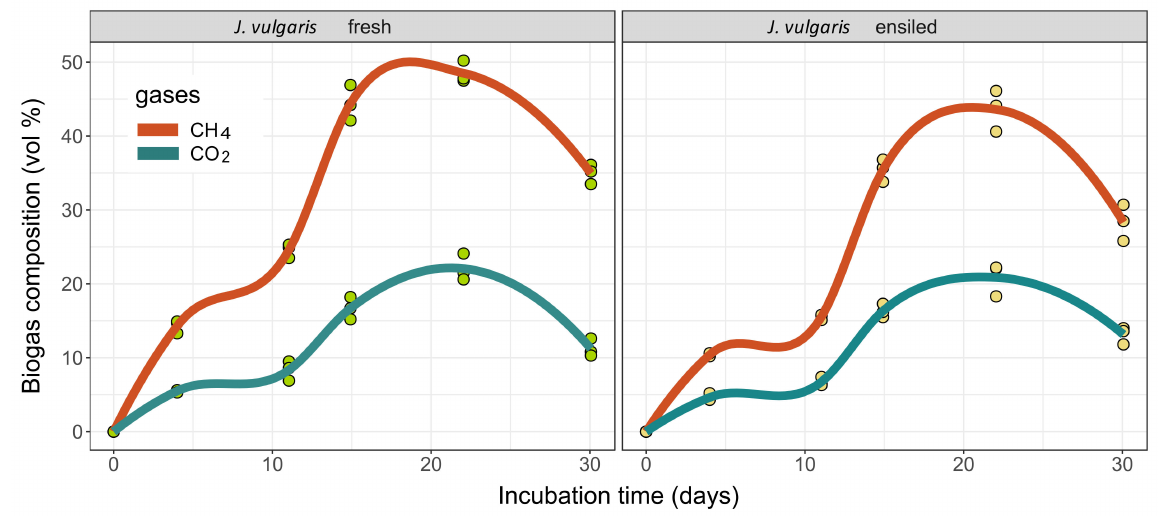
Figure 6. Volume percentages of the two main biogas components methane (CH 4 ) and carbon dioxide (CO 2 ) during the course of the batch wet fermentation period. Dots indicate the measurement results of the individual batch vessels in triplicate. Trendlines were constructed using local regression approaches (loess).